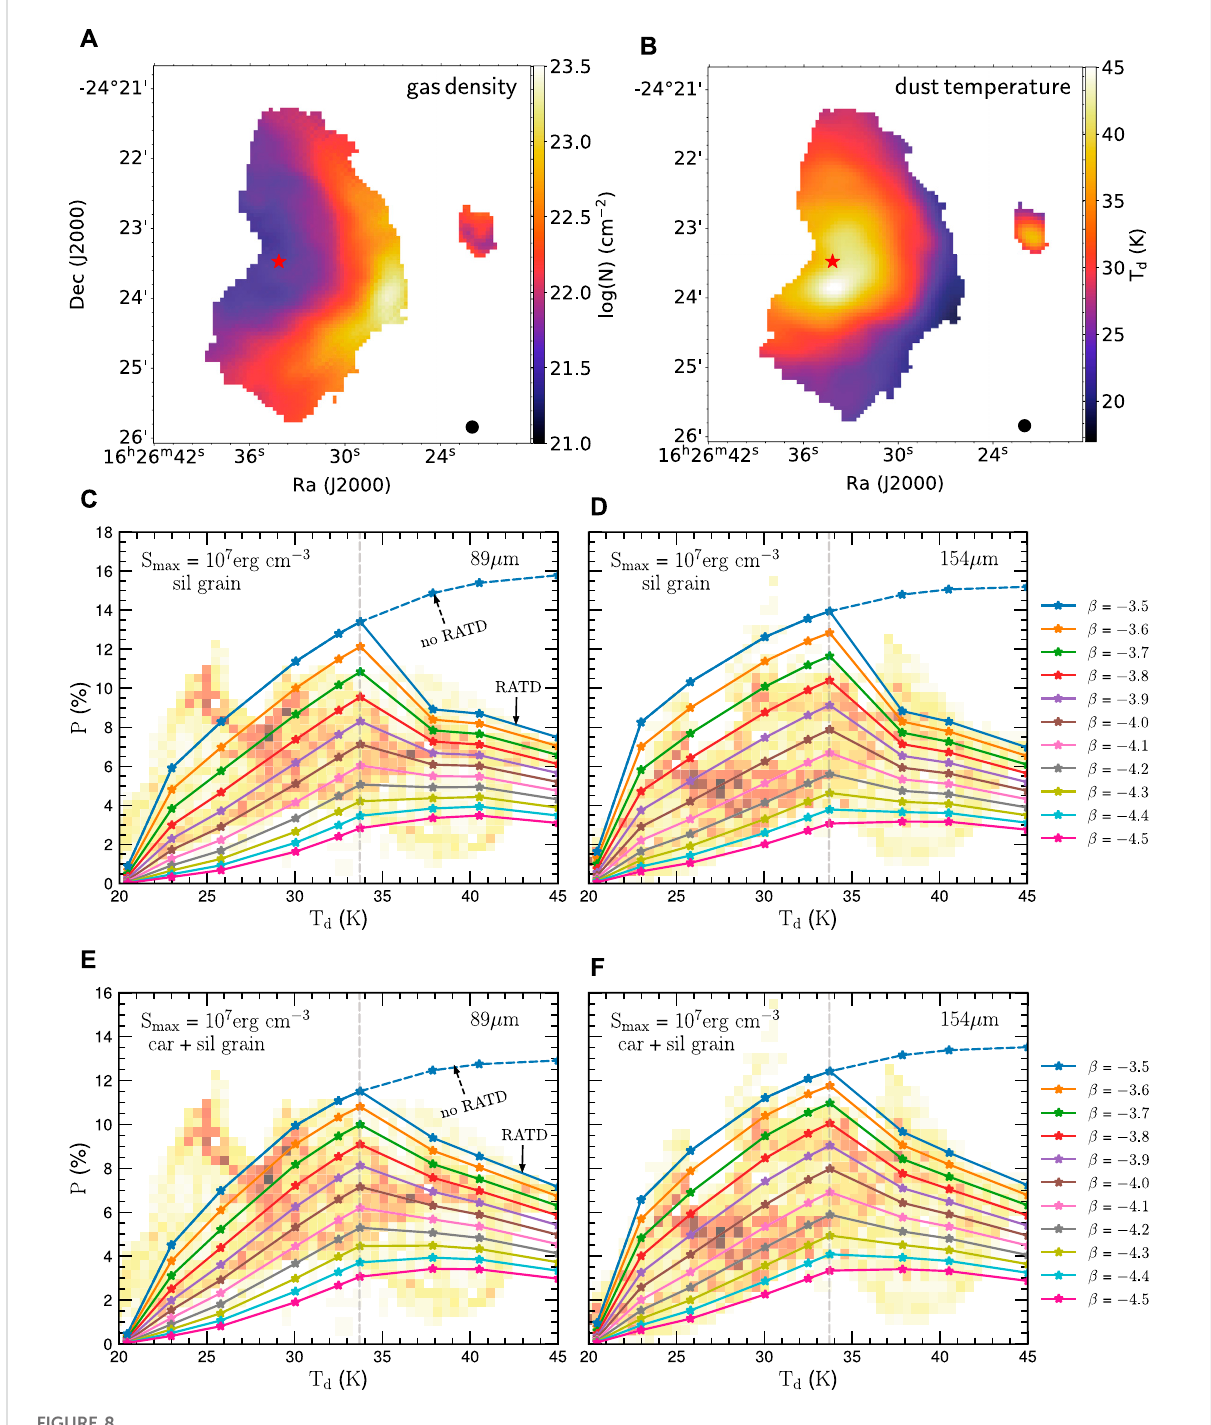
FIGURE 8 Top: gas column density (A) and dust temperature (B) constructed from Herschel data ( fi gure adopted from Santos et al., 2019 and Tram et al., 2021a). A star symbol locates the radiation source Oph-S1. Close to this source, dust is hotter while gas is more diffuse. Middle: 2D-histogram of polarization degree observed with SOFIA/HAWC + at 89 μ m (C) and 154 μ m (D) and dust temperature (background). A dashed line is the prediction byonlytheRAT-Aeffect,whichcouldnotexplainthedecreaseof p for T d > 34 K.ThesolidlinesarethepredictionsmadebyboththeRAT-Aand RAT-D effects for only silicate grains with the grain-size distribution of dn / da ~ a β . Bottom: Similar to the middle panel but for and a mixture of silicate-carbonaceous grains at 89 μ m (E) and 154 μ m (F) . The RAT paradigm (RAT-A and RAT-D) successfully reproduces both the increase and decrease part of the data. Figures adopted from Tram et al.